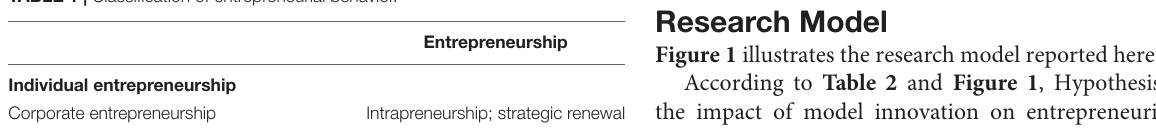
TABLE 1 | Classification of entrepreneurial